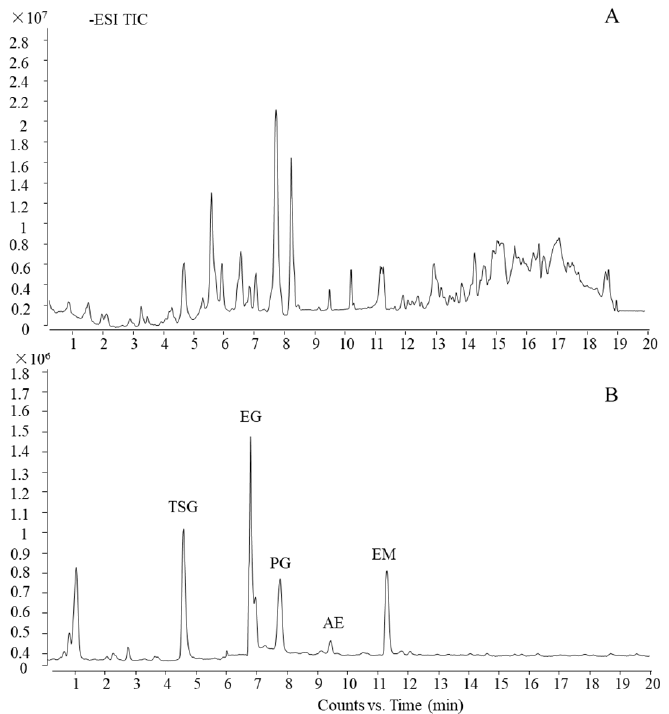
Figure 3. UHPLC-QTOF-MS profile of PM. ( A ) TIC of PM and ( B ) TIC of standard substances.